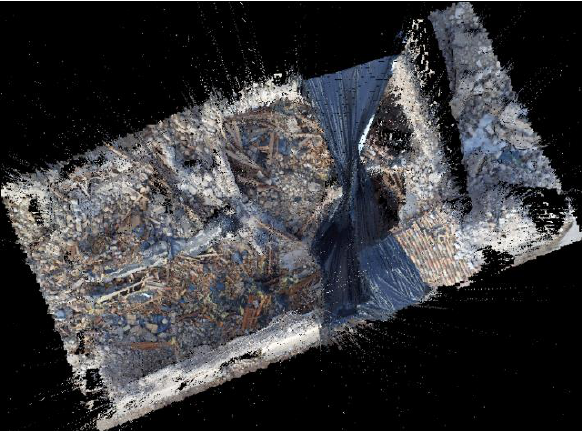
Figure 12. Estimated precisions [m] along Y axis.